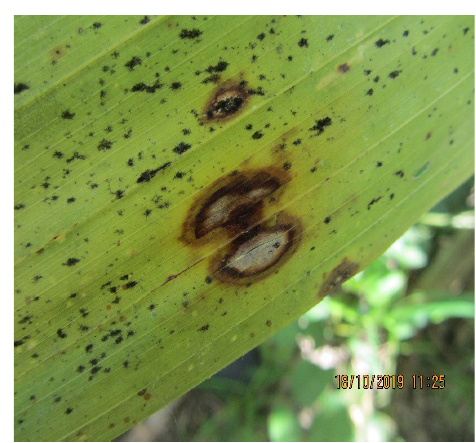
Figure 3. Banana leaf spots caused by Mycosphaerella fijiensis ; the causative agent of black leaf streak